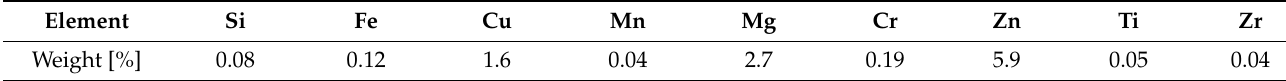
Table 1. Chemical composition of the AA7075-T6 alloy.